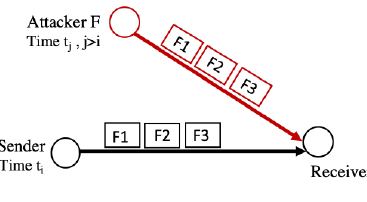
Figure 8. Replay attack.